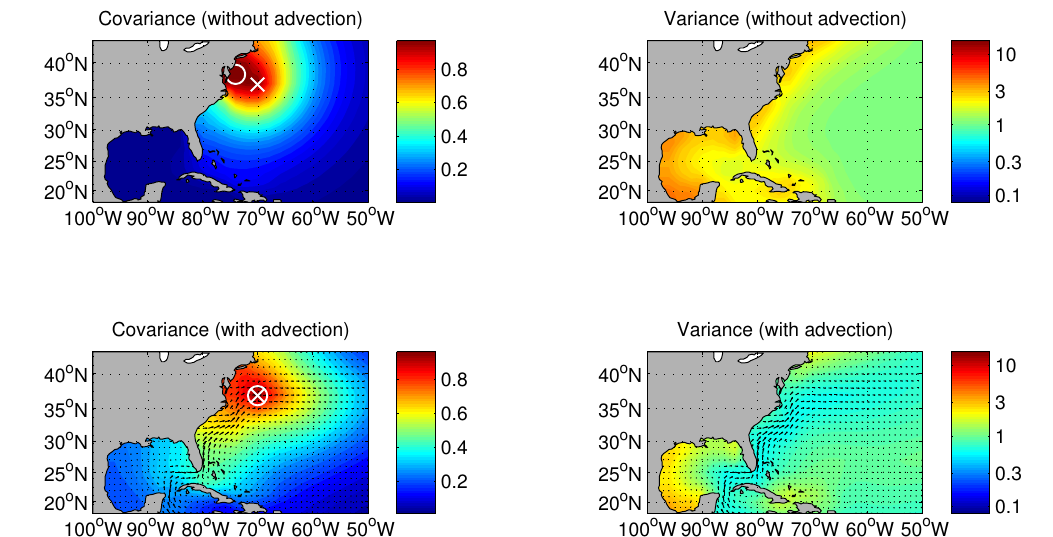
Fig. 6. 2-D case: background error covariance (left panels) relative to the location marked by a cross, and surrounding grid points and background variance (right panels). The upper (lower) panels correspond to the case without (with) advection constraint. The circle indicates the grid point with the highest covariance.